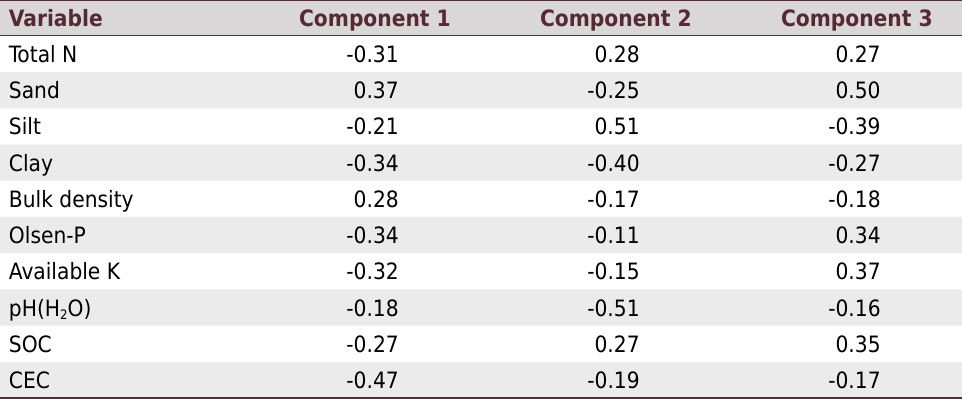
Table 2. Principal Component Analysis eigenvectors